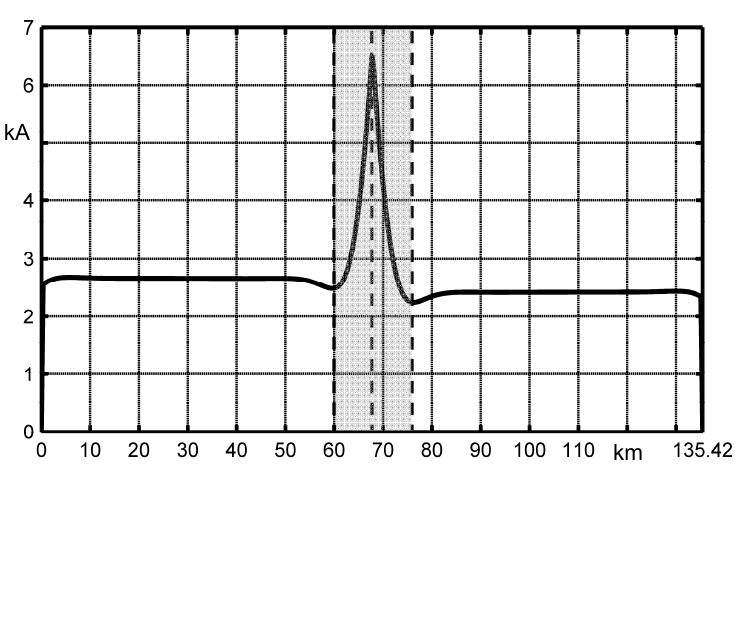
Figure 18. Earth wire current magnitude | I